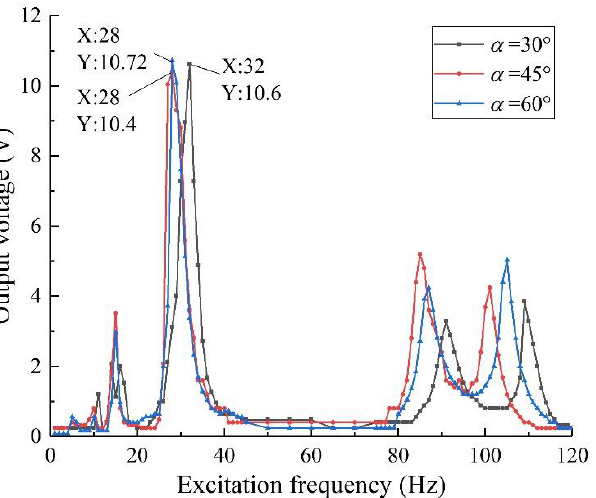
Figure 18. Output voltage of multi-dimensional vibration harvesting with different oblique angles.